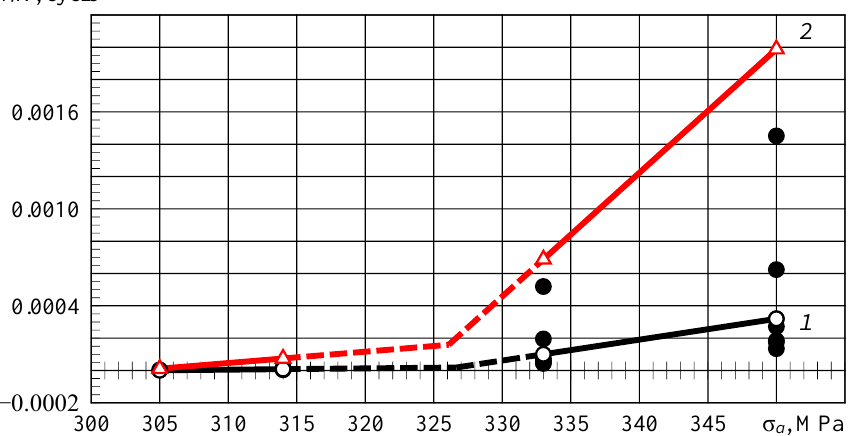
Fig. 5. The amplitude dependence of the damage per cycle of specimens from carbon fiber reinforced